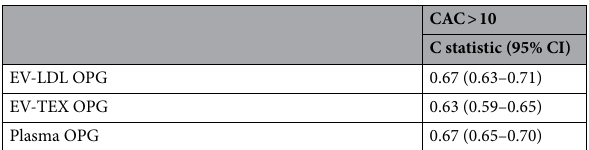
Table 4. C-statistics for OPG to detect significant CAC. CAC > 10 refers to the clinical scenario with a binary outcome for the coronary artery calcium score defined as < 10 or > 10. EV extracellular vesicle, EV-LDL and EV-TEX different subpopulations of